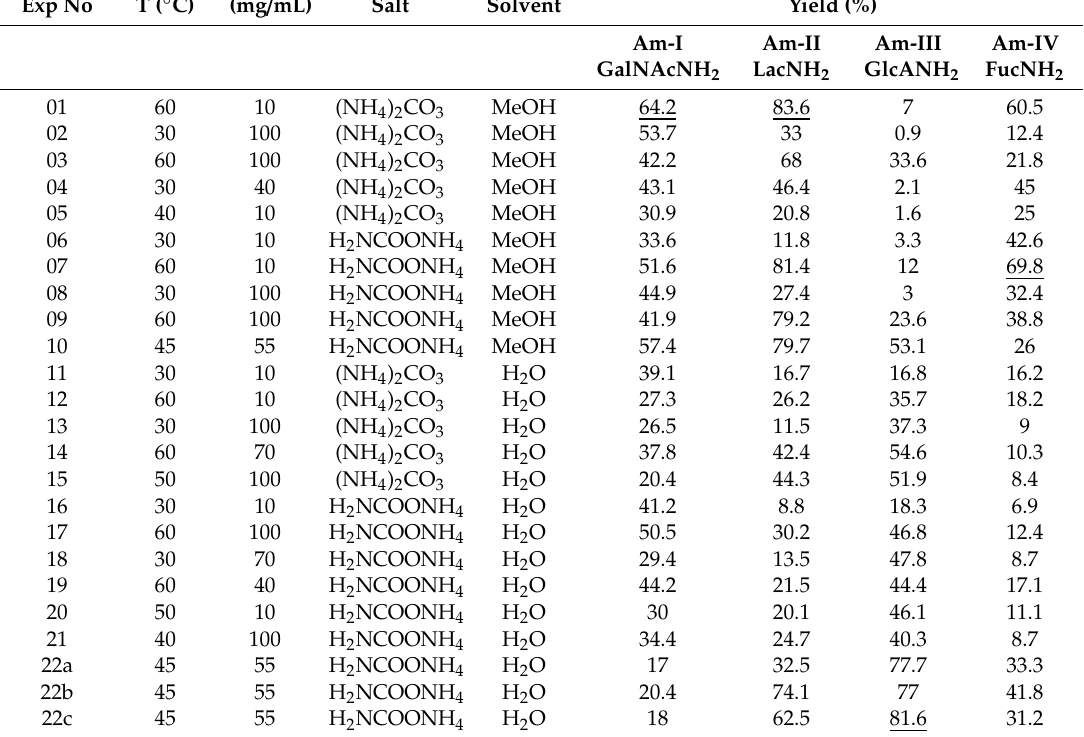
Table 1. Reaction conditions and yields of amination. Highest yields are indicated by underscores. Exp